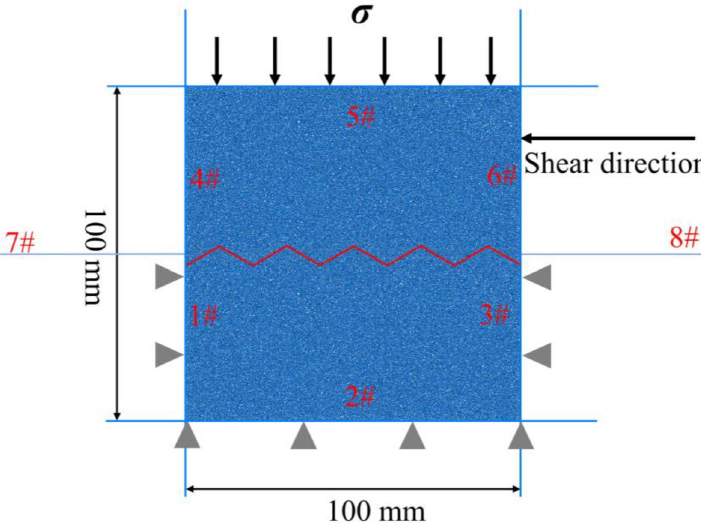
Figure 5. Diagram of the particle flow code (PFC) numerical simulation